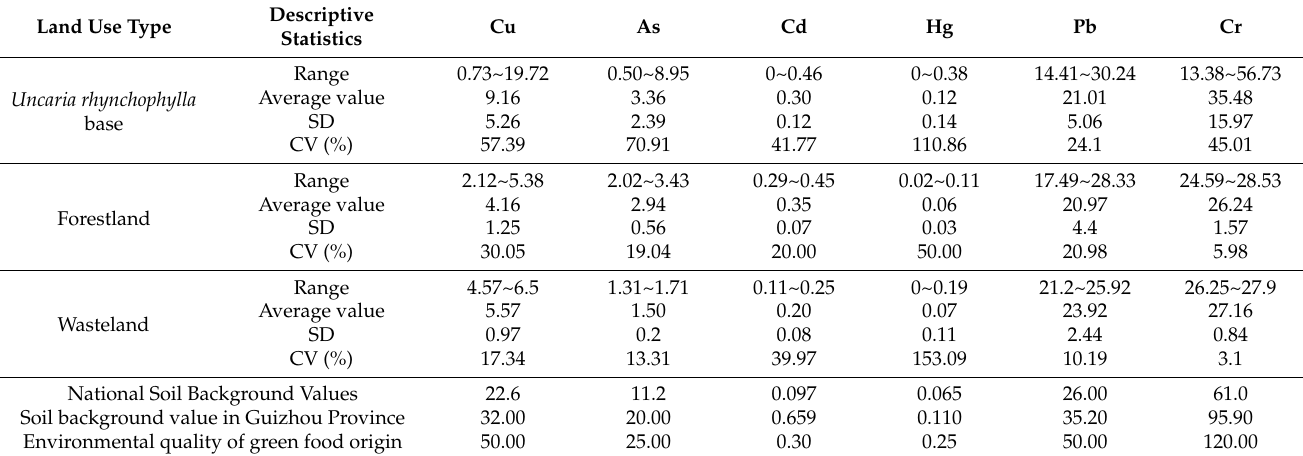
Table 4. Soil heavy metal content in different land use patterns (mg/kg).